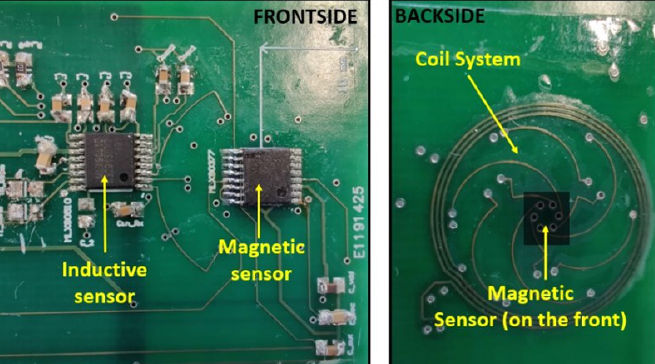
Figure 5. Pictures of the hybrid sensor prototype. The front side ( left picture) of the PCB contains the two sensor ICs (magnetic and inductive). The back side ( right picture) contains the coil system. The magnetic sensor is placed at the center of the coil system.